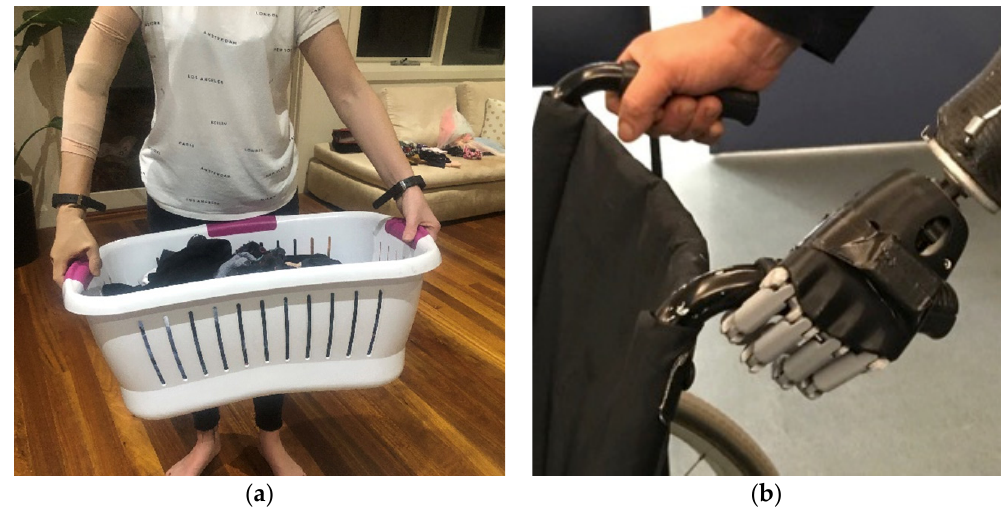
Figure 4. The Self Grasping Hand as fitted on participants ( a ) with glove; ( b ) without. Objective measurement of prosthesis wear and use (Activity Monitoring):